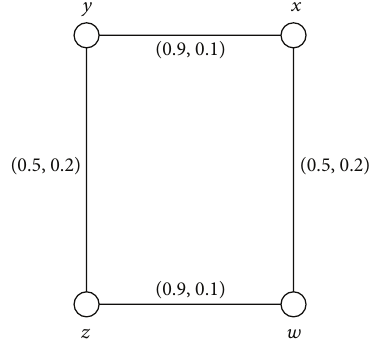
Figure 6: Connected intuitionistic fuzzy graph.